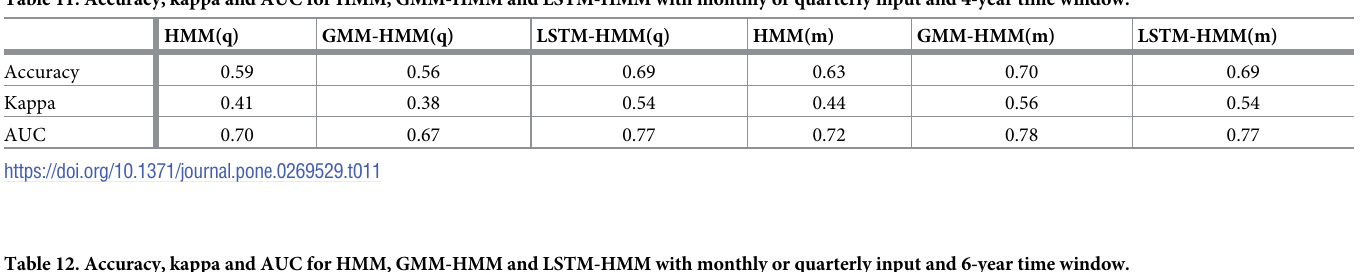
Table 12. Accuracy, kappa and AUC for HMM, GMM-HMM and LSTM-HMM with monthly or quarterly input and 6-year time window.